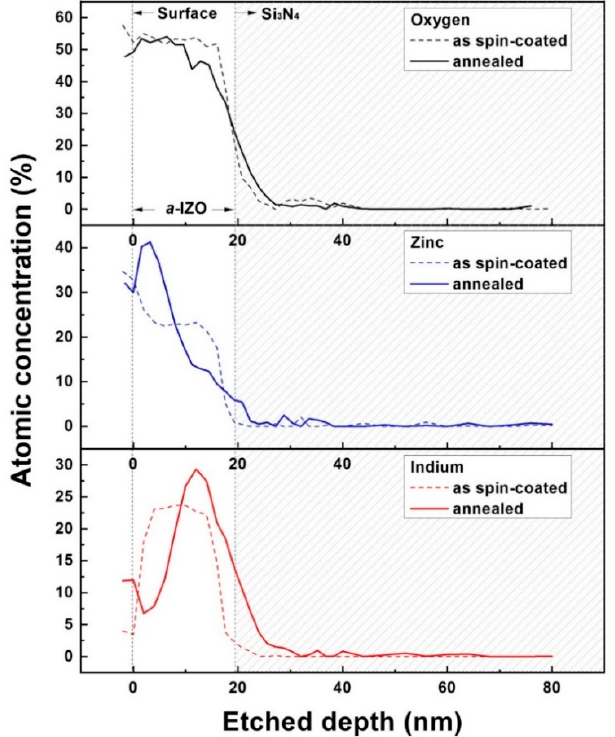
Figure 5. AES graph in terms of the depth of a -IZO film. Measured results (dashed line) after spin coating and soft baking (110 °C) and (solid line) after annealing at 550 °C.